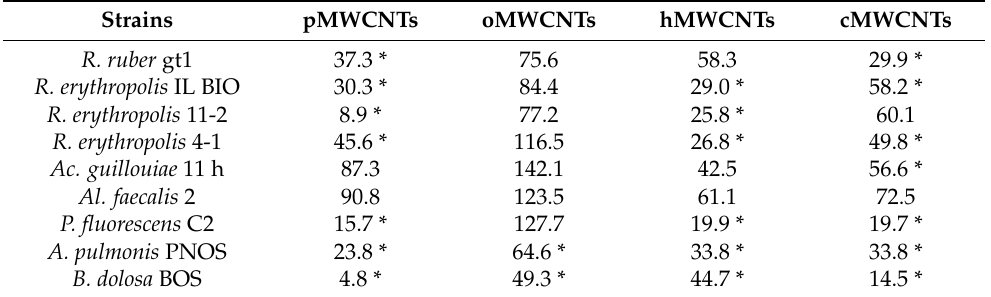
Table 2. Metabolic activity of biofilms after exposure to pristine and functionalized MWCNTs, %.